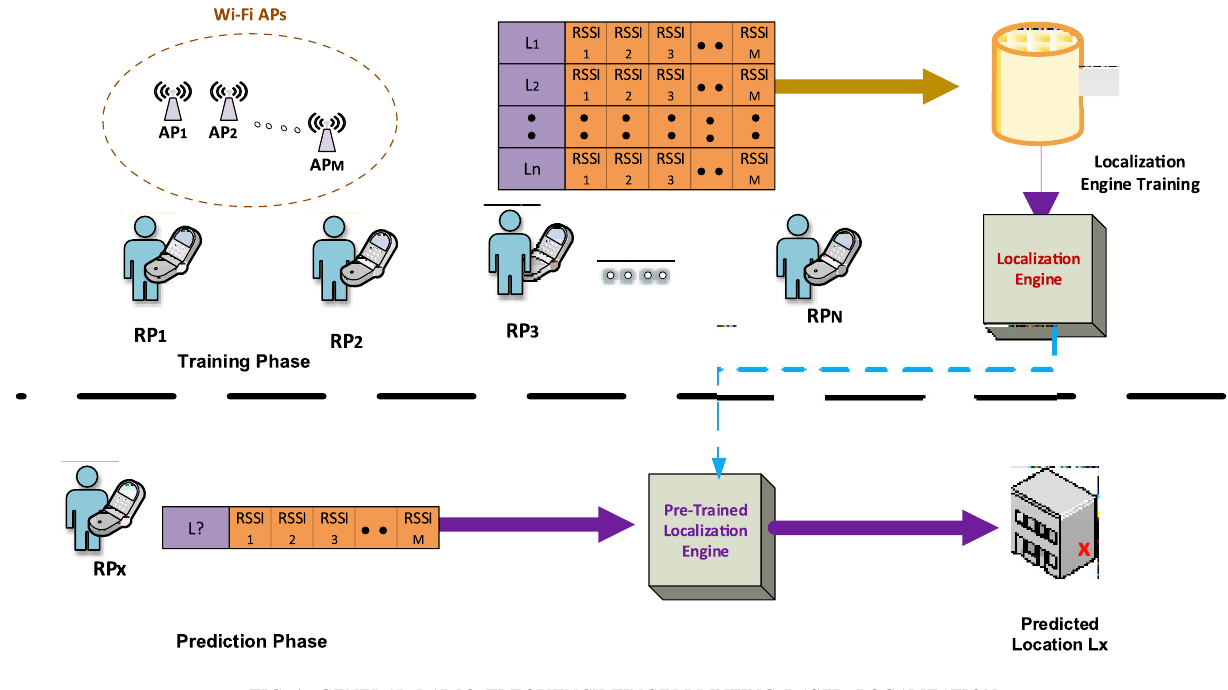
FIG. 1. GENERAL RADIO FREQUENCY FINGERPRINTING BASED